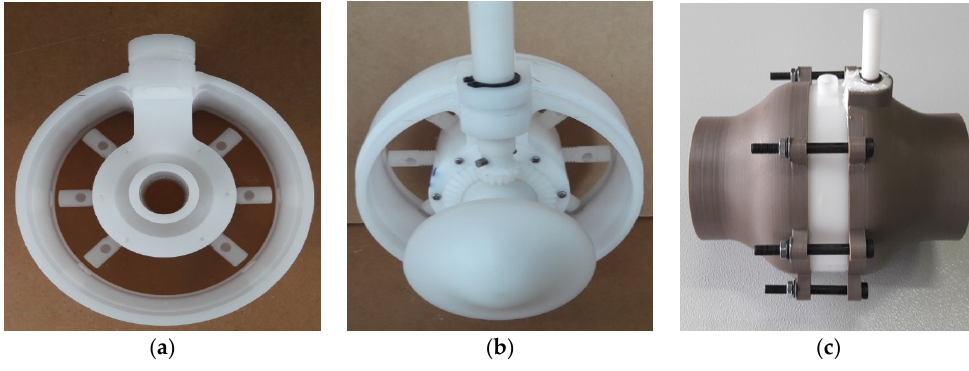
Figure 18. New mixer: ( a ) Main body of mixer; ( b ) The new mixer without covers; ( c ) The new mixer with covers